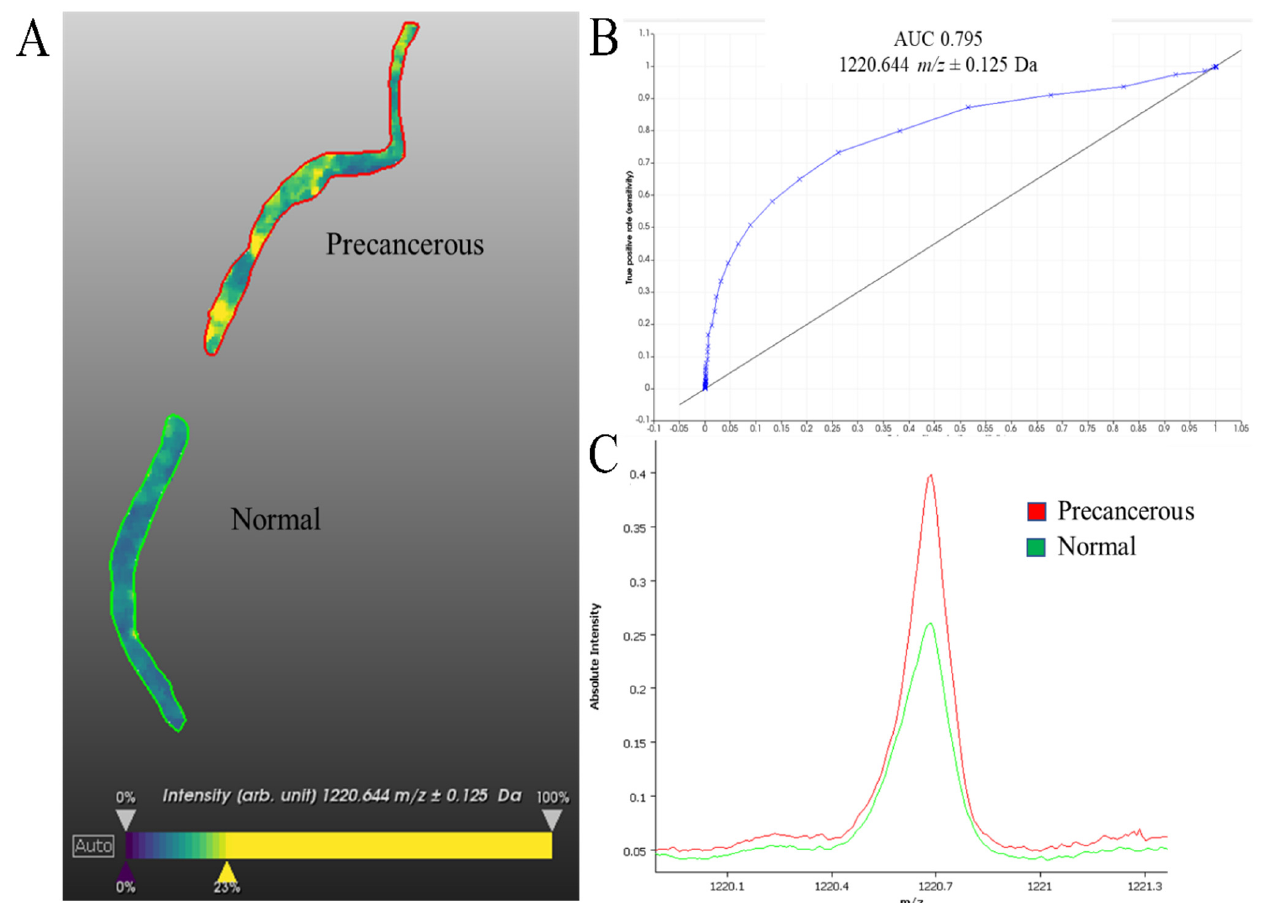
Figure 3. MALDI MSI on an endometrial tissue ( A ) Representative ion intensity image of m/z 1220.644 ± 0.125 Da. ( B ) The ROC curve of m/z 1220.644 (AUC 0.795) for precancerous versus normal region. ( C ) Comparative spectra of m/z 1220.644 Da between precancerous and normal region. Scale bar is 1.4 cm, ion intensity ranges from blue (lowest) to yellow (highest).